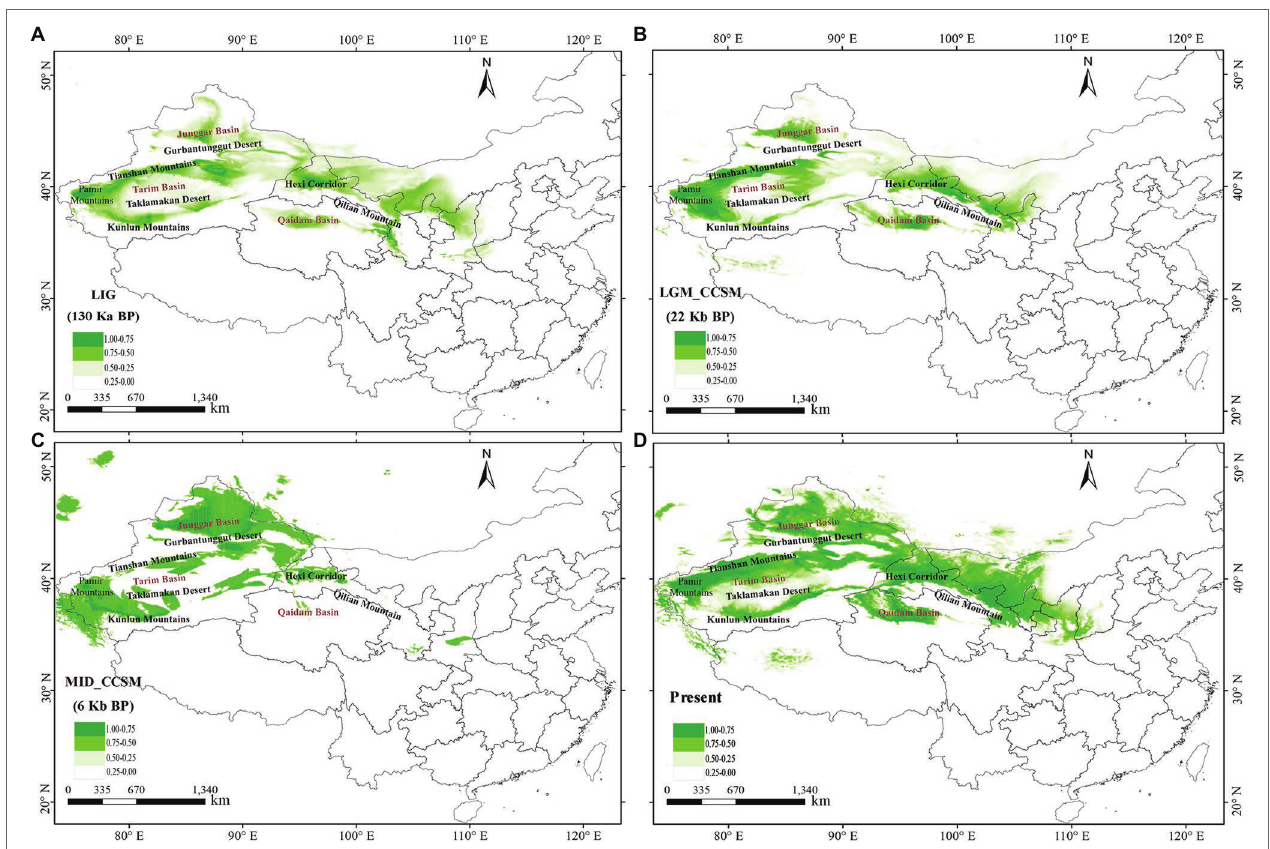
FIGURE 5 | Model of areas climatically suitable for Lycium ruthenicum at different times. (A) Last interglacial (LIG; ca. 0.13–0.14 Mya BP). (B) Last glacial maximum (LGM; ca. 0.02 Mya BP) under Community Climate System Model (CCSM). (C) Mid Holocene (MID; ca. 0.006 Mya BP) under CCSM. (D) Present time